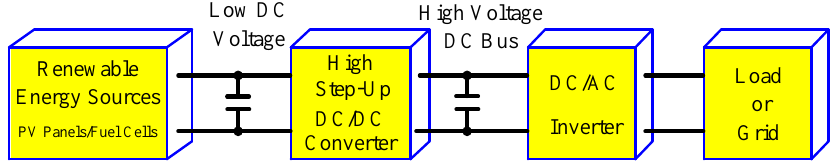
Figure 1. Diagram of a renewable energy power system.